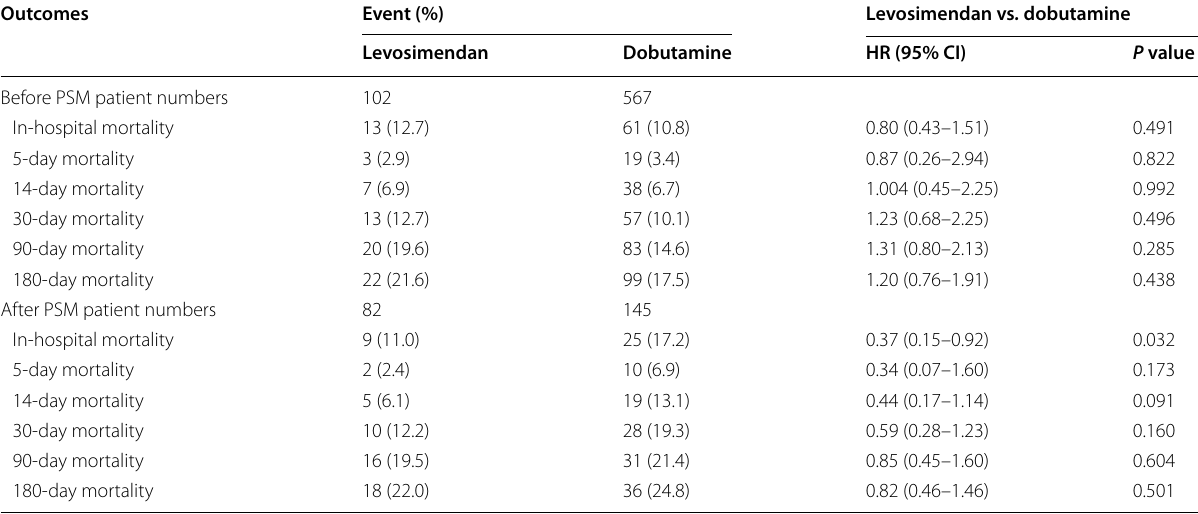
HR hazard ratio, CI confidence interval, PSM propensity score matching